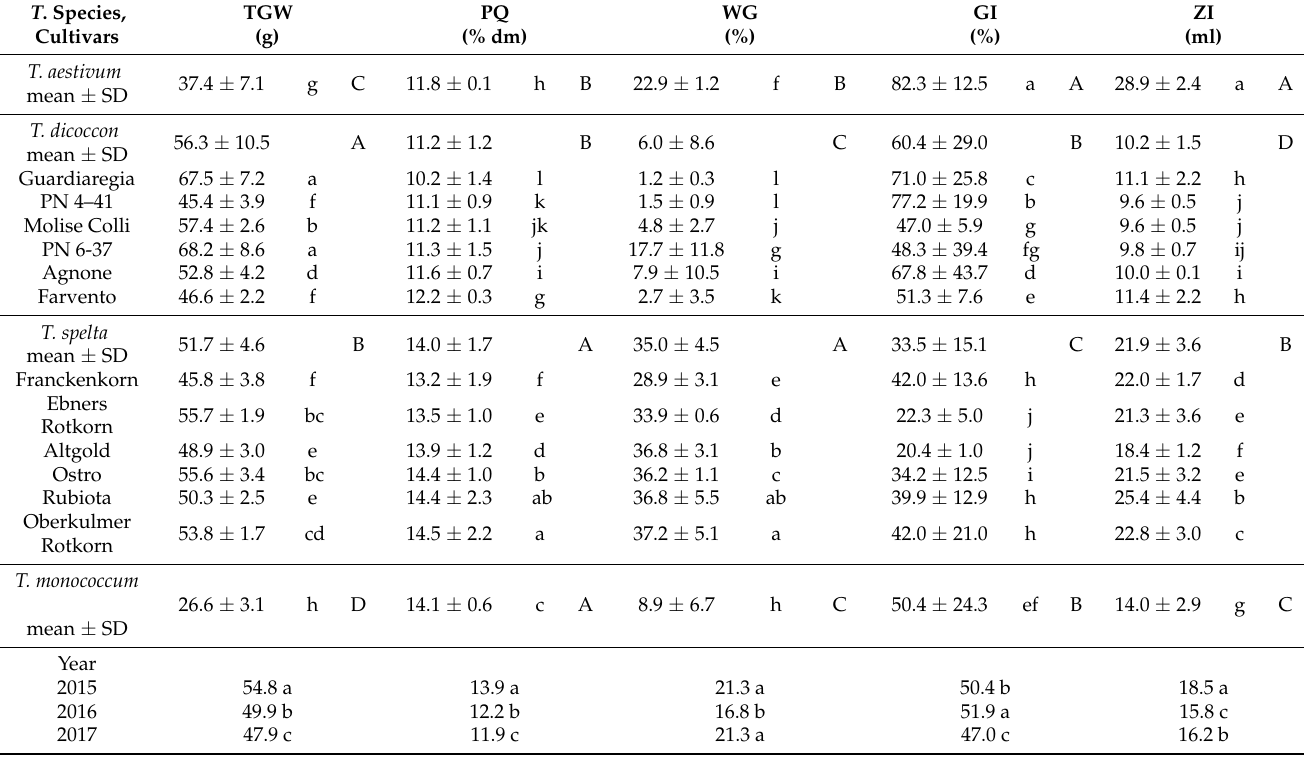
Table 6. Indirect baking quality parameters of Triticum species and